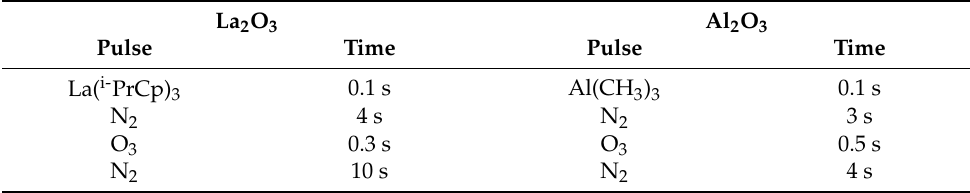
Table 1. Single cycle growth parameters of ALD.